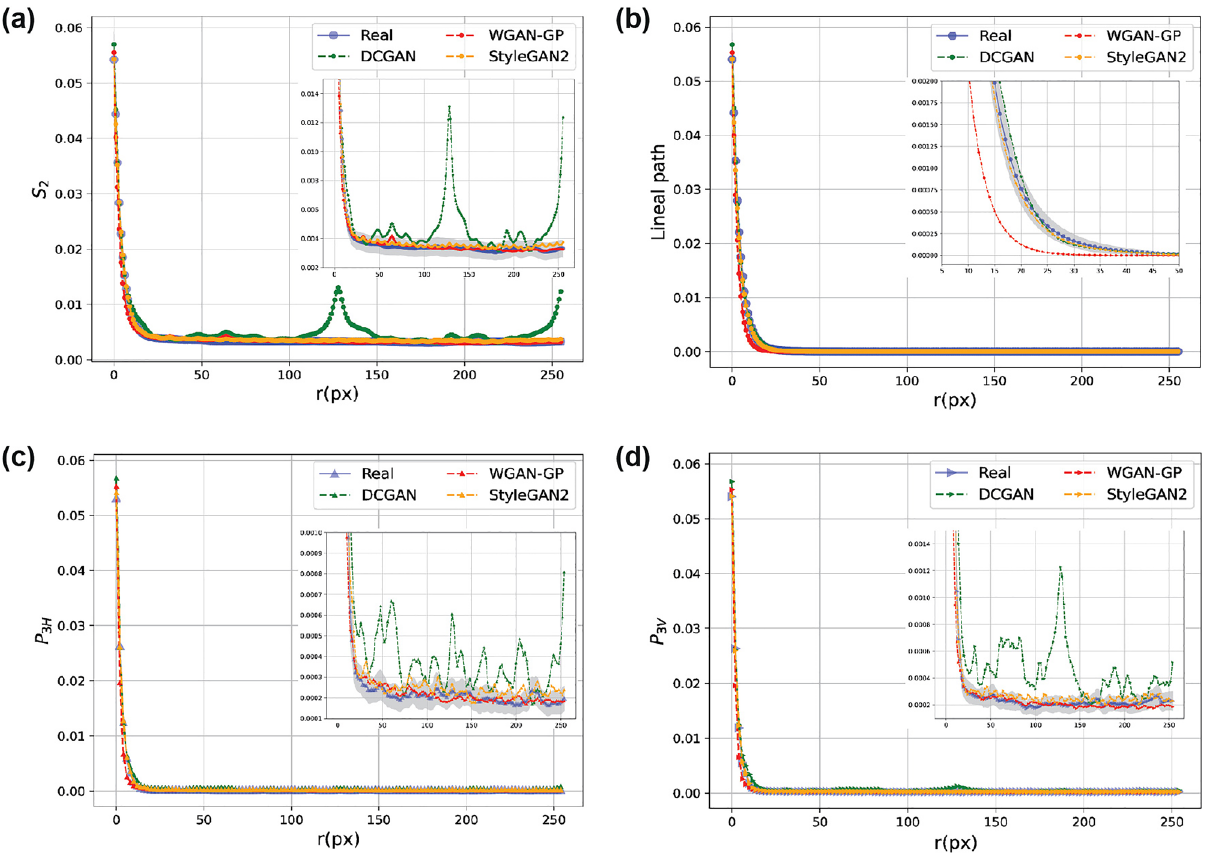
Figure 9. Quantification of original and reconstructed meta-igneous microstructures via different GANs. P 4 and P 6 are not presented due to insignificant amounts of